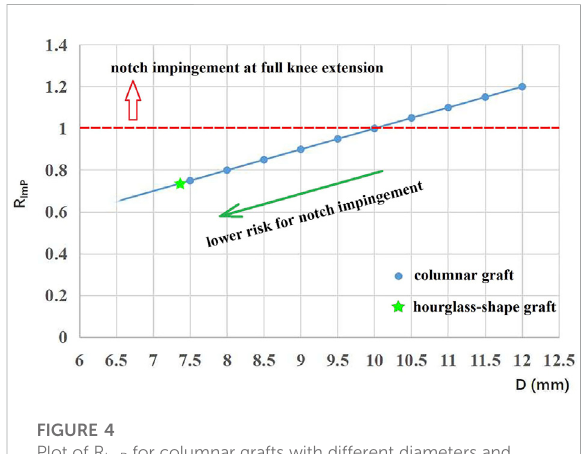
FIGURE 4 Plot of R ImP for columnar grafts with different diameters and the hourglass-shaped